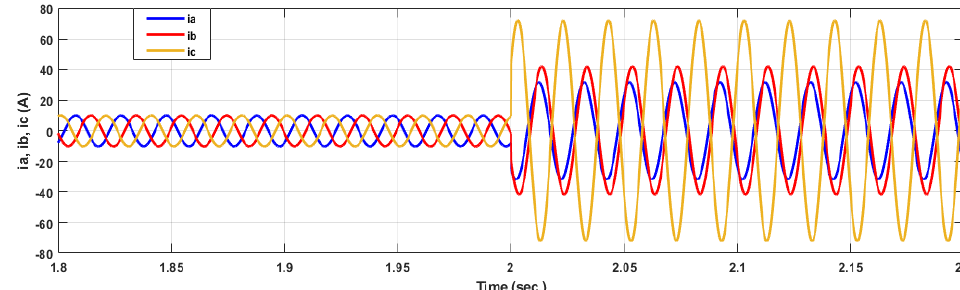
Figure 32. Current signals for 25% short circuit fault in phase c.